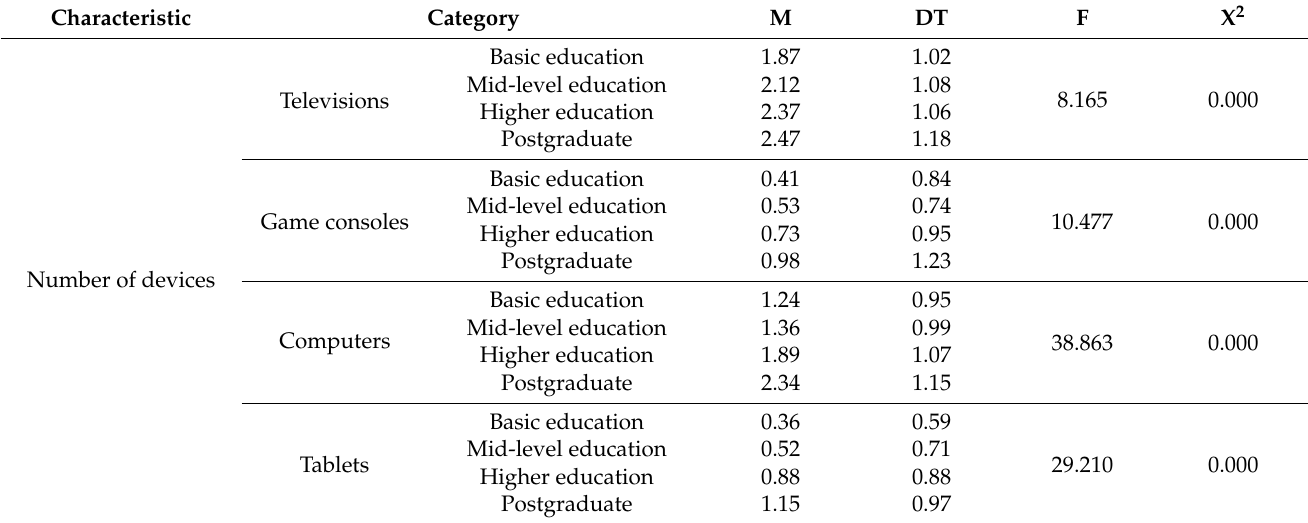
Table 6. Number of devices according to the educational level of Ibero-American